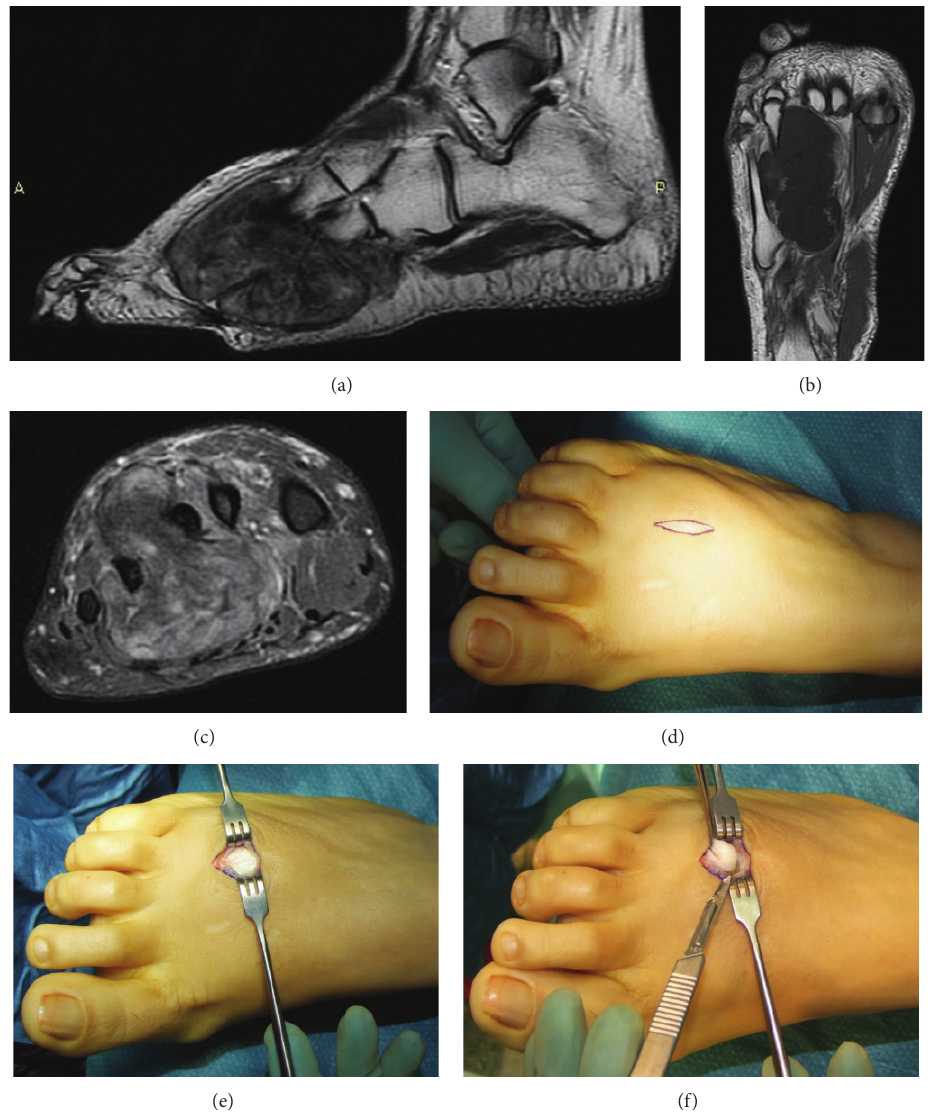
Figure 1: Sagittal MRI T2 (a), coronal MRI T1 (b), and axial MRI fat sat (c) scans of the right foot show heterogeneous intratumoral hypointensive signal on T1 and hyperintensive signal on T2. Incisional biopsy is made by (d) a small longitudinal incision between the second and third metatarsals; then (e) once the tumor capsule is found, (f) the tissue sampling is done with cold knife. Diagnosis: soft tissue